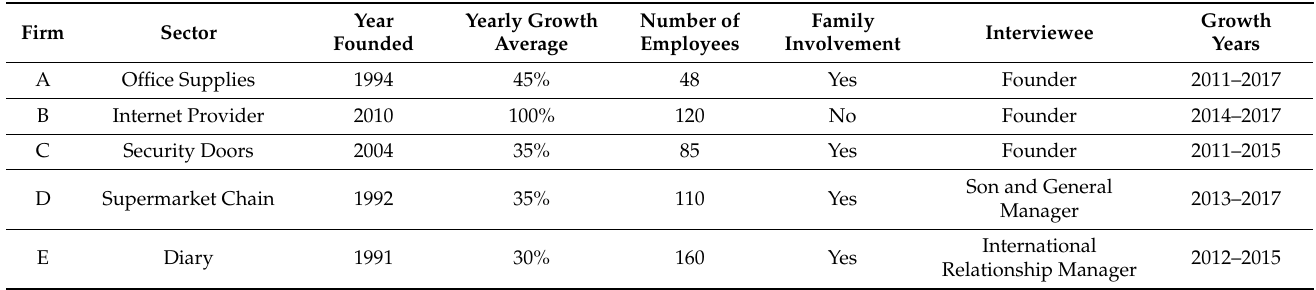
Table 1. Information on the case